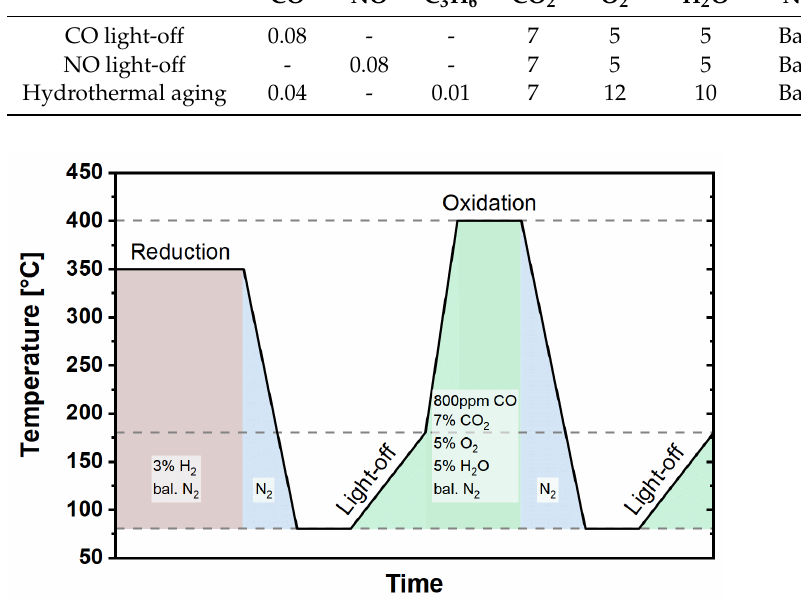
Figure 8. Schematic overview on the experimental procedure during the CO light-off experiments. Calculating the turnover frequency (TOF) allows comparing the catalysts among each other by taking their catalytic activity and the dispersion values obtained by CO chemisorption measurements into account. Equation (2) defines the TOF [s − 1 ] as TOF = . V as the volumetric flow rate [m 3 s − 1 ], X as the conversion (0 ≤ X ≤ 1), c 0 ( CO ) with as volumetric inlet concentration of CO [ppmv], p as pressure [Pa], R as gas constant (R = 8.314 J K − 1 mol − 1 ), T as temperature [K], m noble metal as mass of the noble metal